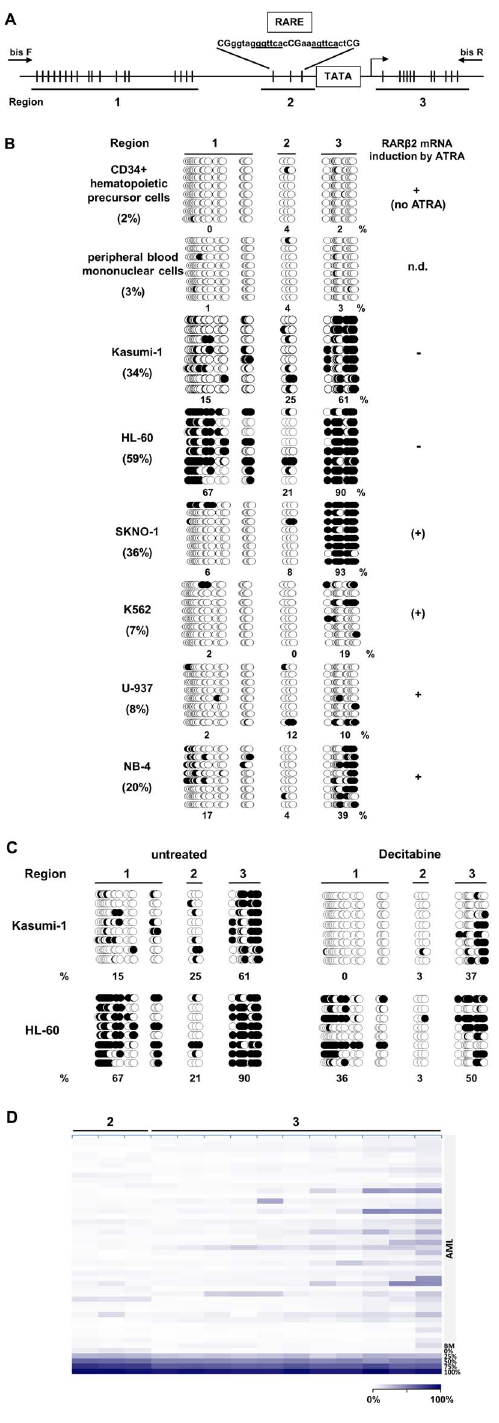
Figure 4. Differential methylation of the RAR b 2 promoter/ exon1 in human myeloid leukemia cells. ( A ) Map of the RAR b 2 promoter region with indication of amplicons 1–3 analyzed by bisulfite sequencing (positions of forward (bis F) and reverse (bis R) primers are shown), pyrosequencing and quantitative real-time PCR of ChIP precipitates. RARE: Retinoic Acid Response Element. Vertical ticks indicate single CpGs (region 1:18 CpGs; region 2:3 CpGs; region 3:11 CpGs). Arrow: transcriptional start site. ( B ) Differential DNA methylation of RAR b 2 promoter/exon1 in myeloid cells. Normal CD34 + cells, peripheral blood mononuclear cells and myeloid cell lines NB-4, HL-60, Kasumi-1, SKNO-1, U-937 and K562 were subjected